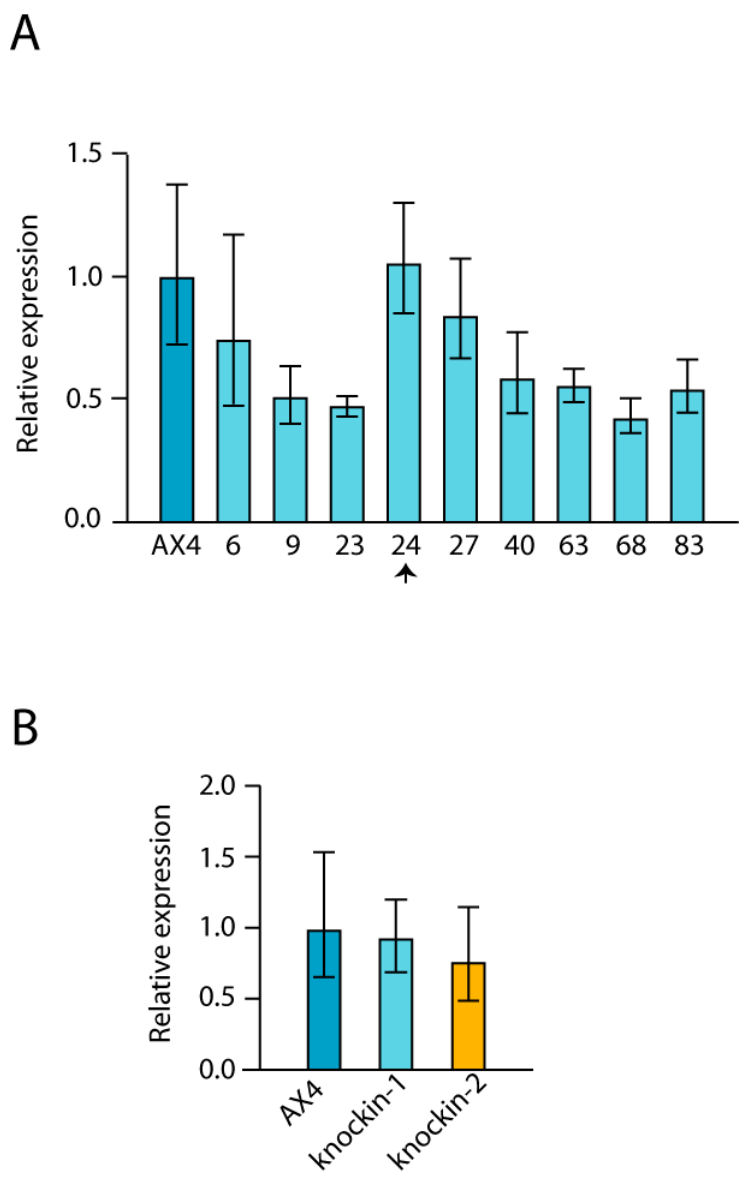
Figure A1. Dkc1 expression in clones obtained by homologous recombination. RNA was isolated from different clones that had incorporated dkc1 by homologous recombination, as determined by the PCR test shown in Figure 2. The relative expression of dkc1 mRNA was determined by reverse transcription and quantitative PCR and compared to that of AX4 cells. Panel A shows the results obtained for several clones corresponding to the knockin-1 generation. Clone numbers are shown in the X-axes. The arrow indicates the clone that was selected for further analysis. Panel B shows the relative expression of the knockin-1 and knockin-2 clones selected for the study after removal of the Blasticidin resistance cassette upon expression of the Cre recombinase. This result is in agreement with the data on dkc1 expression shown in figure 6.